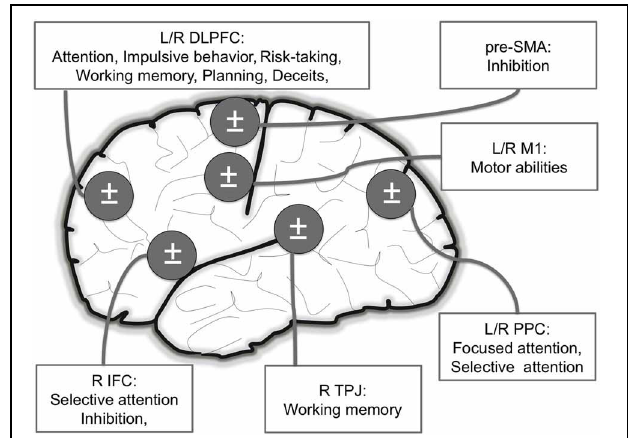
FIGURE 2 | Main brain areas targeted in NIBS studies inducing motor and cognitive (attention, risk-taking, planning and deceptive abilities) enhancements in healthy volunteers. L: Left; R: Right; DLPFC: Dorso Lateral Prefrontal Cortex (attention, risk-taking/impulsivity, planning and deceptive abilities); IFC: Inferior Frontal Cortex (attention and deceptive abilities); PPC: Posterior Parietal Cortex (attention); M1: Primary Motor Cortex (motor); TPJ: temporoparietal junction (working